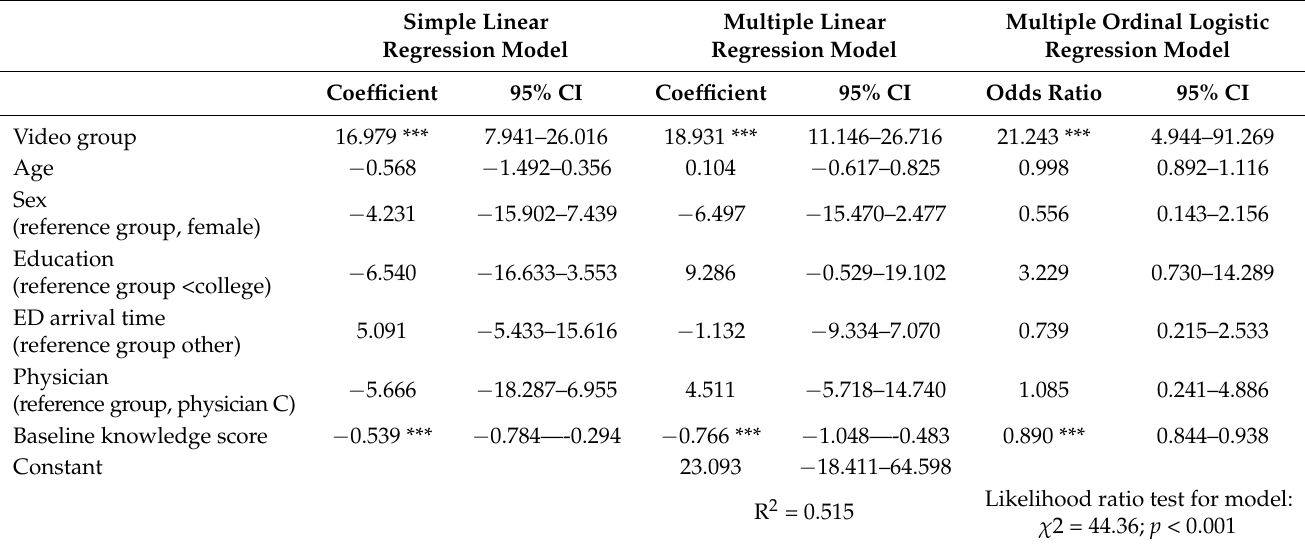
Table 3. Knowledge score difference evaluated using regression models.